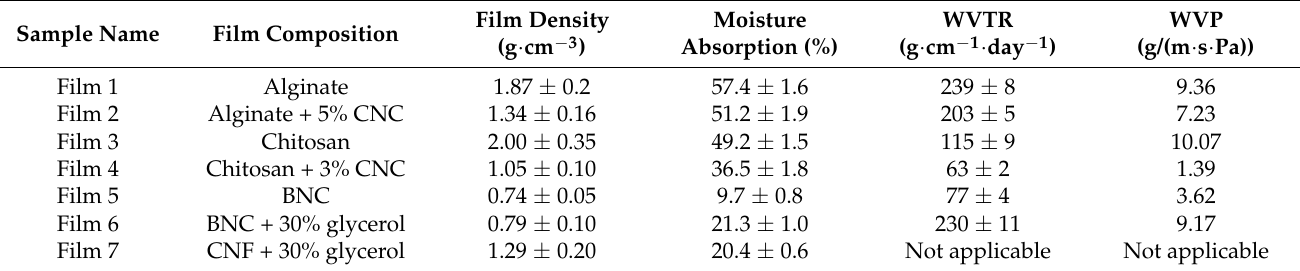
Table 2. Density, moisture absorption, water vapor transmission rate (WVTR), properties of films (values are presented as mean ± SD). Water vapor permeability results (WVP) are presented as a calculated mean